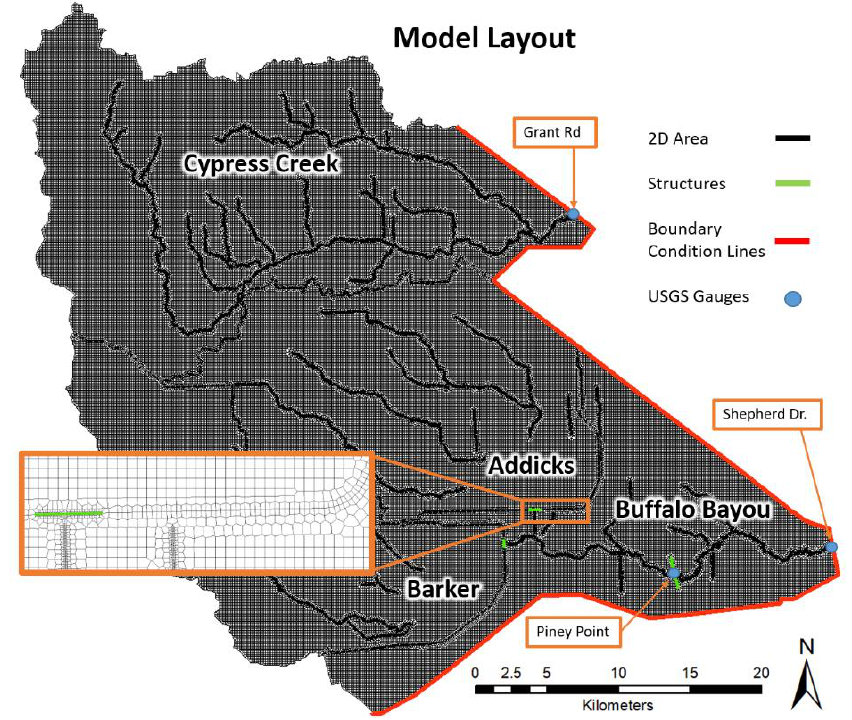
Figure 2. HEC-RAS 2D model domain, boundary conditions, and gauge locations.